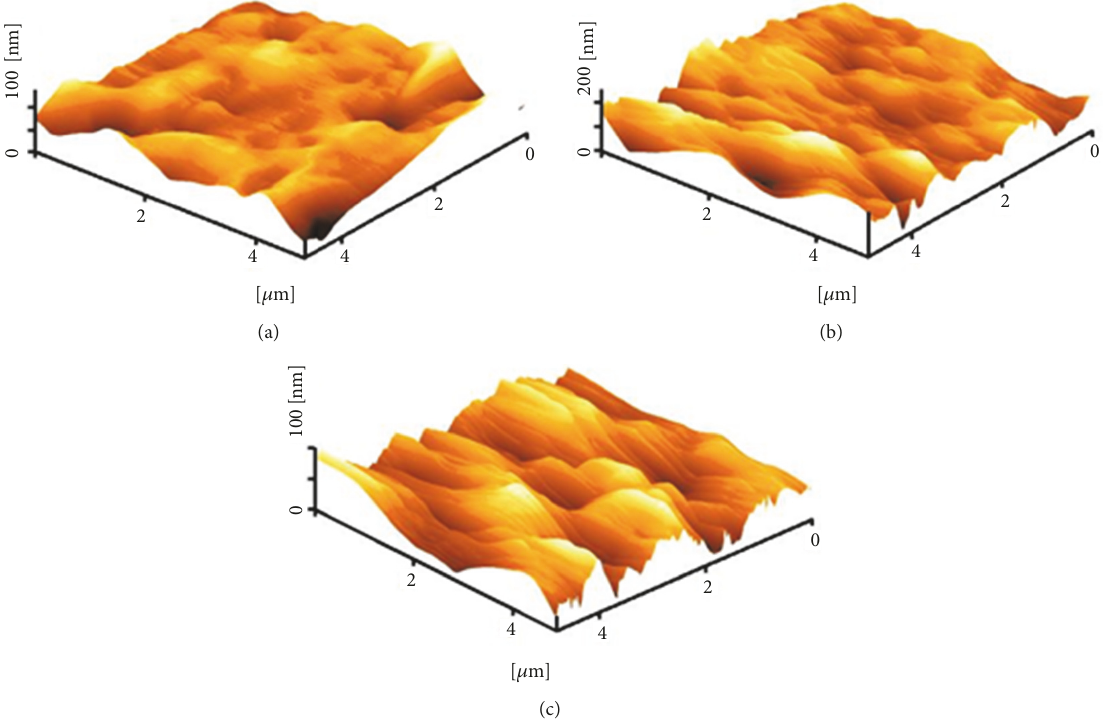
Figure 2: AFM3D heightimages of the treated PEEK with (a) 3-, (b) 5-, and (c) 10-minutesulphonation times after applying the compression